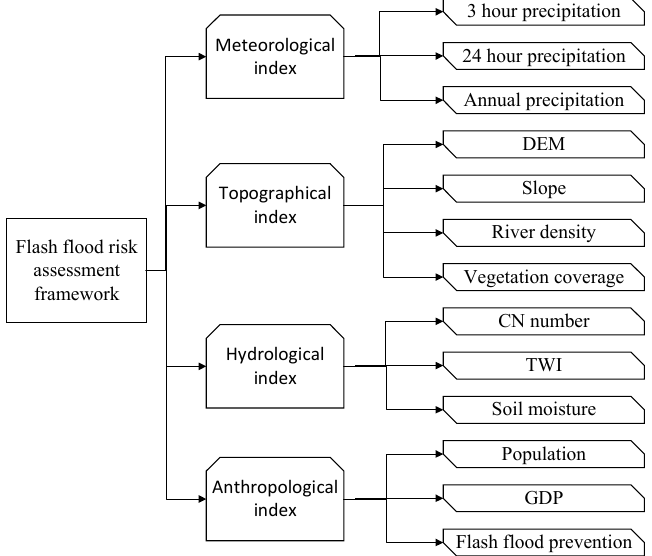
Figure 2. Explanatory factors affecting flash flood risk in this study.